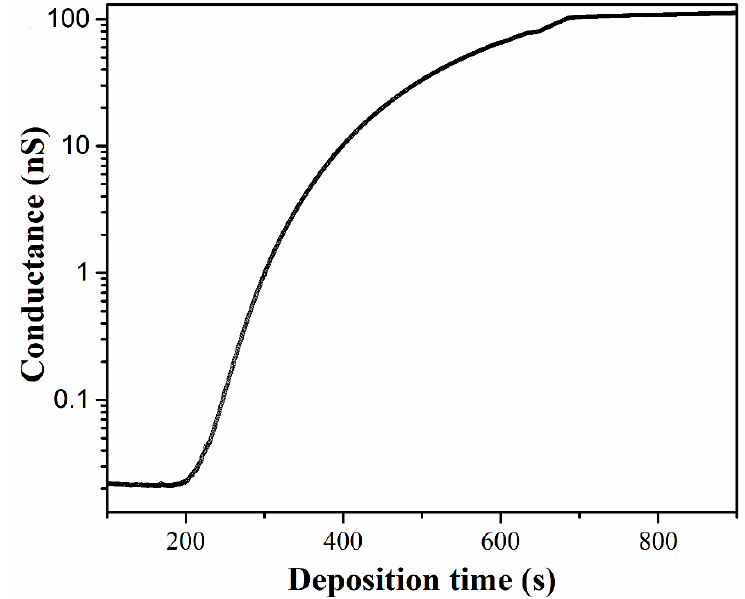
Figure 3. Electron conductance of the Pd NP film monitored during the NP deposition process. Materials 2020 , 13 , x FOR PEER REVIEW